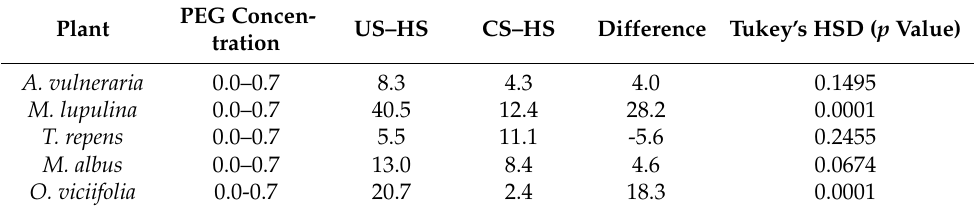
Table A4. Results of Tukey’s HSD test—HS, all